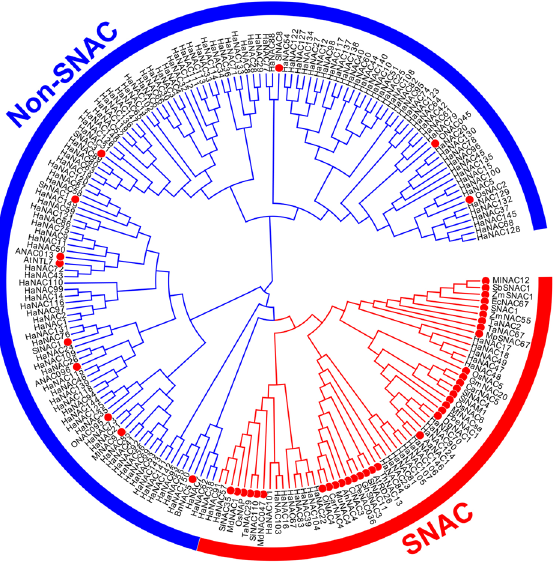
Figure 7. A phylogenetic tree generated using 47 reported NACs enhancing plant tolerance to abiotic stress and HaNACs from sunflower. Red dots indicated NACs reported could improve abiotic stress tolerance in